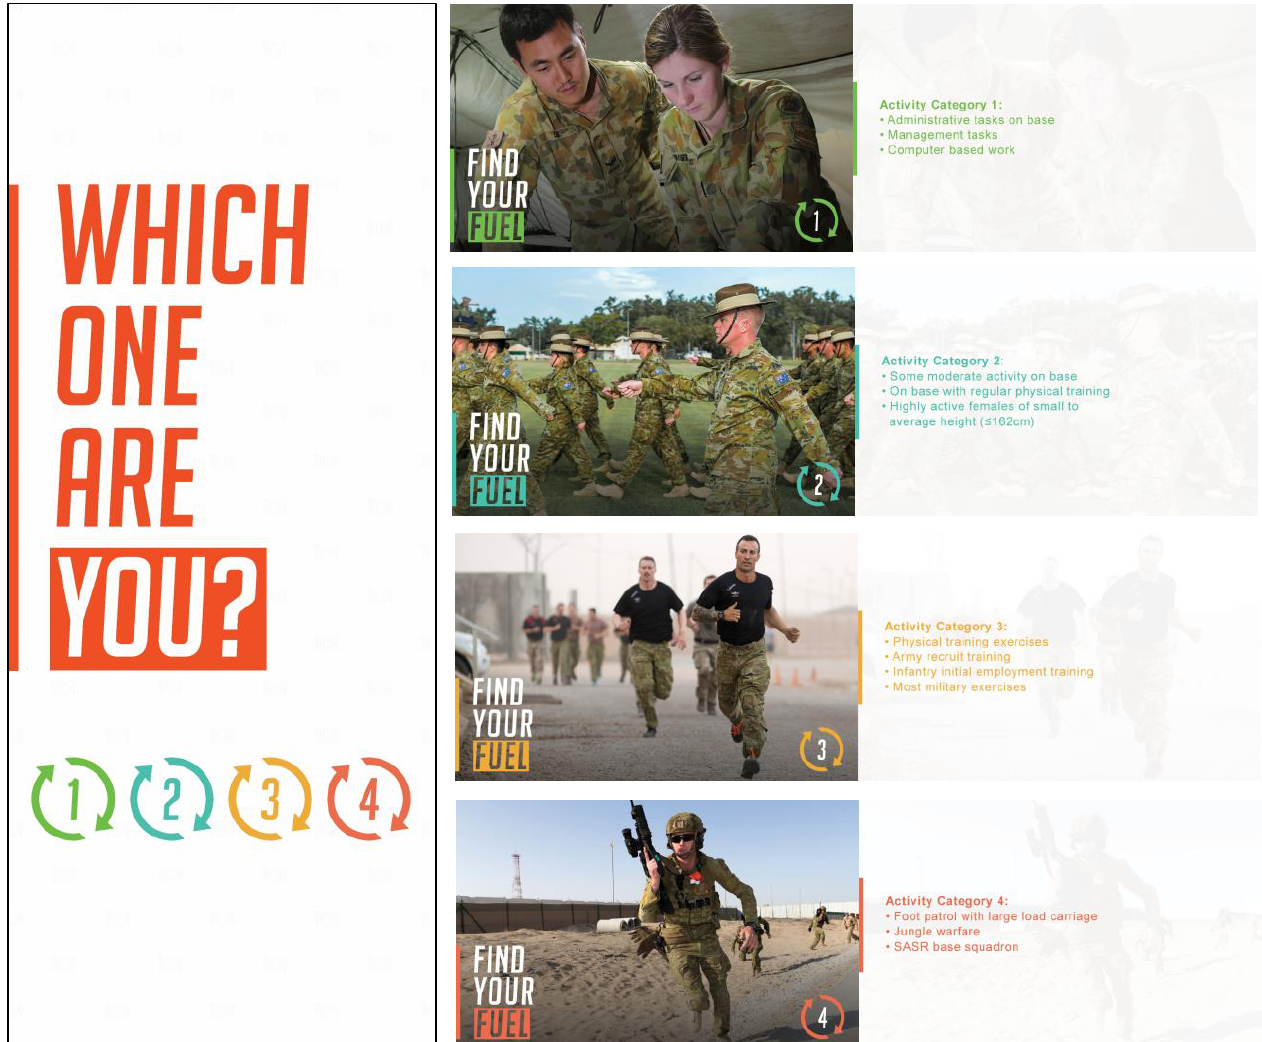
Figure 1. Examples of banners and cards showing activity categories.